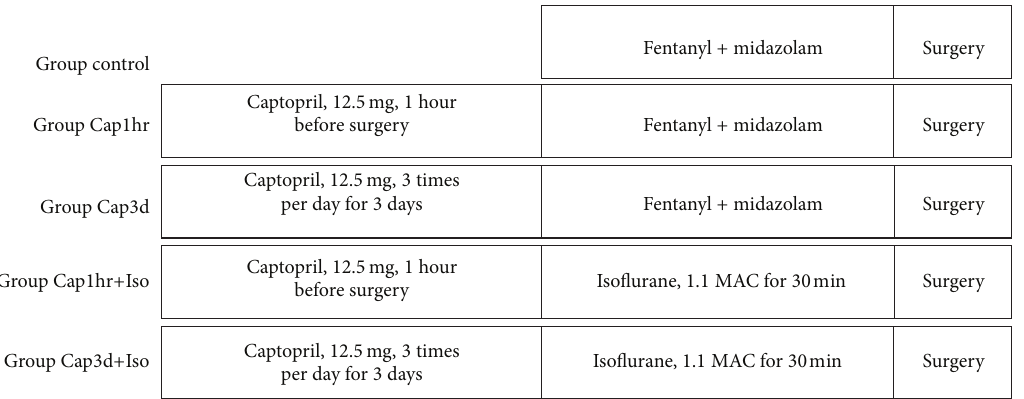
Figure 1: Protocol used in experimental groups. Patients were pretreated without or with captopril for 1 hour (Cap1hr, 12.5 mg, oral administration) or 3 days (Cap3d, 12.5mg, 3 times per day, oral administration) before surgery. After induction, all patients received continuous infusions of fentanyl at 0.6 𝜇 g ⋅ kg −1 of body weight ⋅ min −1 and pancuronium bromide at 15 𝜇 g ⋅ kg −1 of body weight ⋅ min −1 during surgery. The anaesthesia protocol in various groups is as follows: anaesthesia was maintained either with fentanyl and midazolam (group control, Cap1hr, and Cap3d) or with isoflurane 1.1 MAC (minimum alveolar anesthetic concentration) end tidal before surgery (group Cap1hr+Iso or